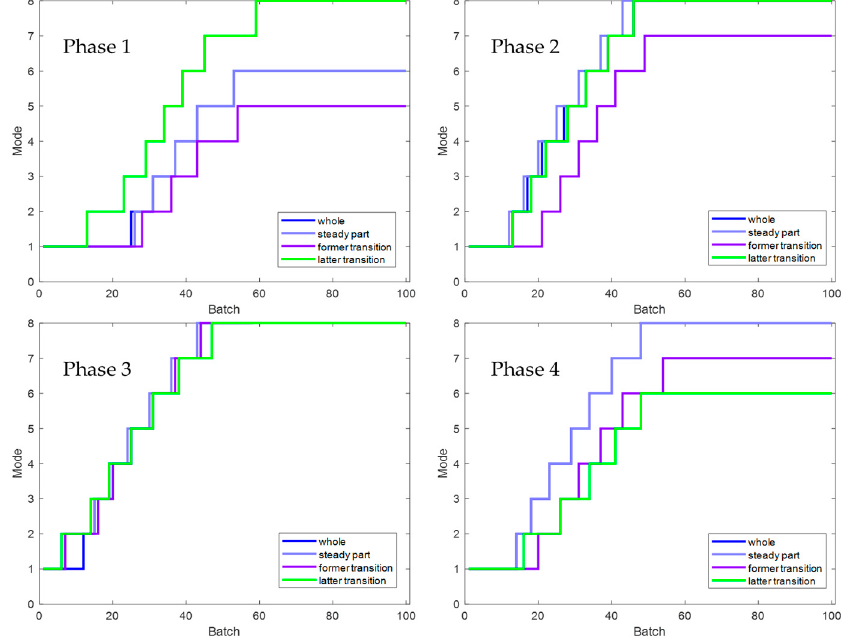
Figure 11. Mode division results in the batch direction of each phase.